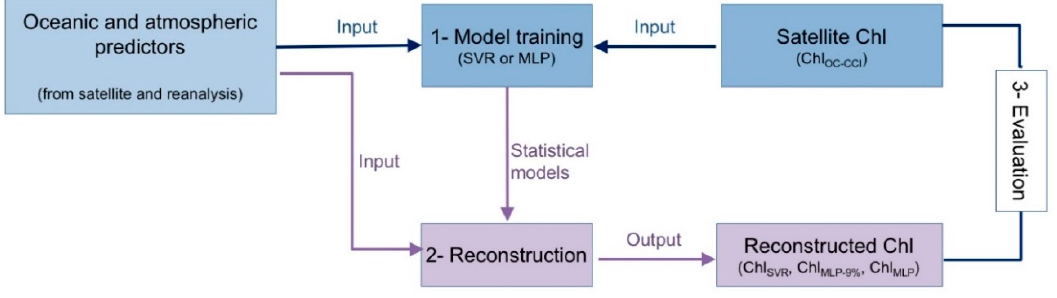
Figure 1. Three-step procedure to train the machine learning models, reconstruct surface Chlorophyll-a concentration (Chl) and evaluate the statistical model skills over 1998–2015.